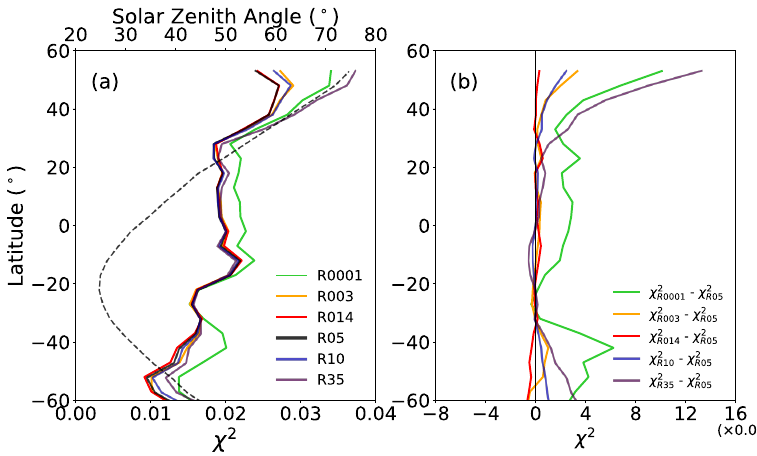
Figure 3. ( a ) The residual sum of squares of mean A diff value ( χ 2 ; see Equation (5)) using the R0001, R003, R014, R05, R10, and R35 ice particle models on December solstices from 2012 to 2015. The dotted curve (and top scale) is the median SZA as a function of latitude. ( b ) The residual sum of squares of mean A diff value using each corresponding model minus the residual sum of squares of mean A diff value using the R05 ice particle model as a function of latitude.